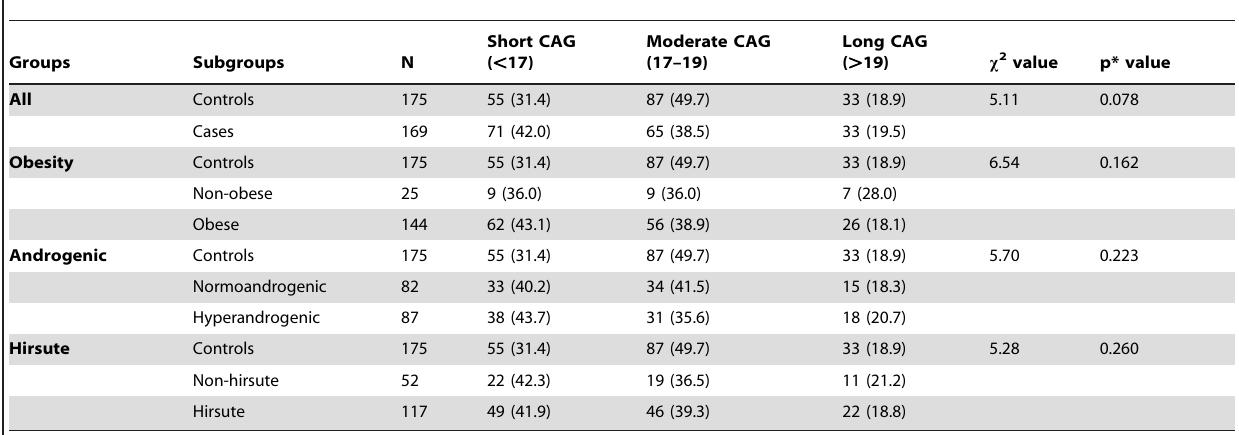
Table 3. Frequency distribution (%) of CAG bi-allelic mean length in three CAG length categories (short, moderate, and long).